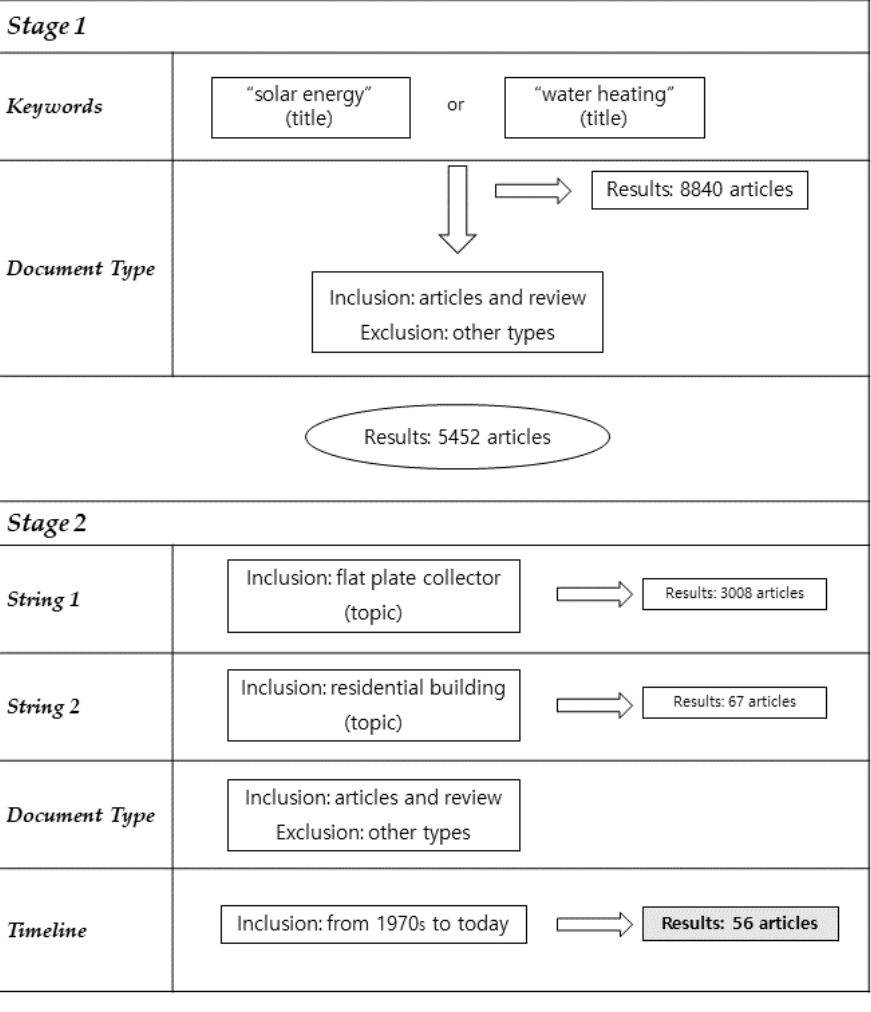
Figure 1. Description and refinement of the search steps to obtain the final sample in residential solar heating using flat-plate collectors.